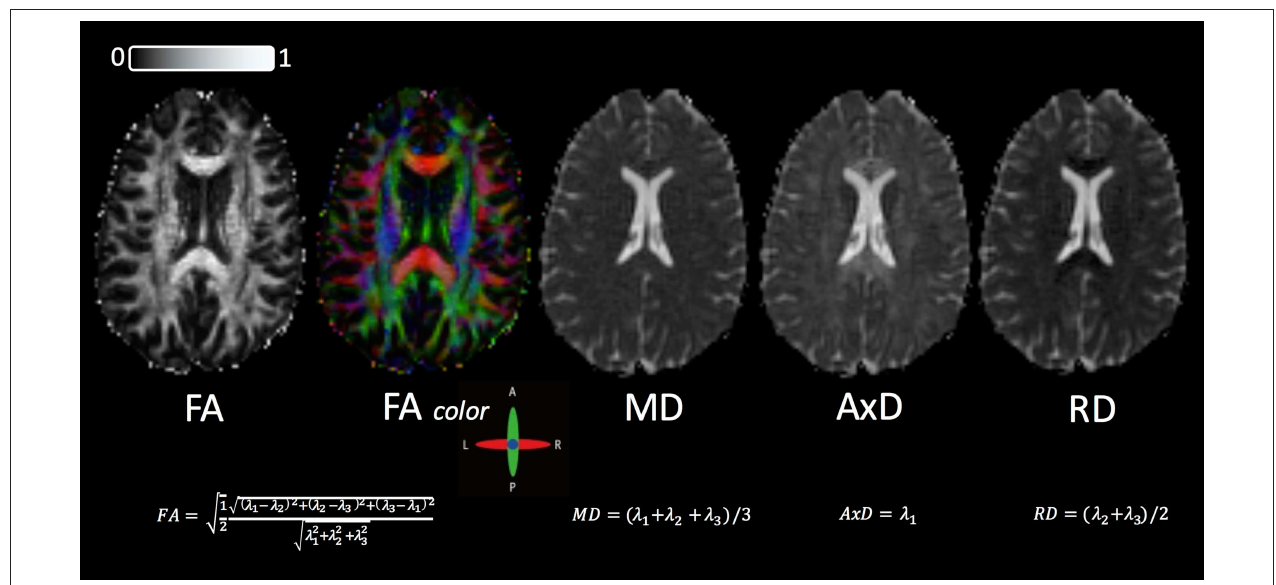
FIGURE 3 | Standard DTI maps, from a healthy volunteer, created by DSI Studio with a DTI diffusion scheme with a total of 67 diffusion sampling directions. The b value was 1,000 s/mm 2 . The in-plane resolution was 2mm, and the slice thickness was 2mm. FA, fractional anisotropy; MD, mean diffusivity; AxD, axial diffusivity; RD, radial diffusivity. The range of FA in between 0 (isotropic diffusion) and 1 (anisotropic